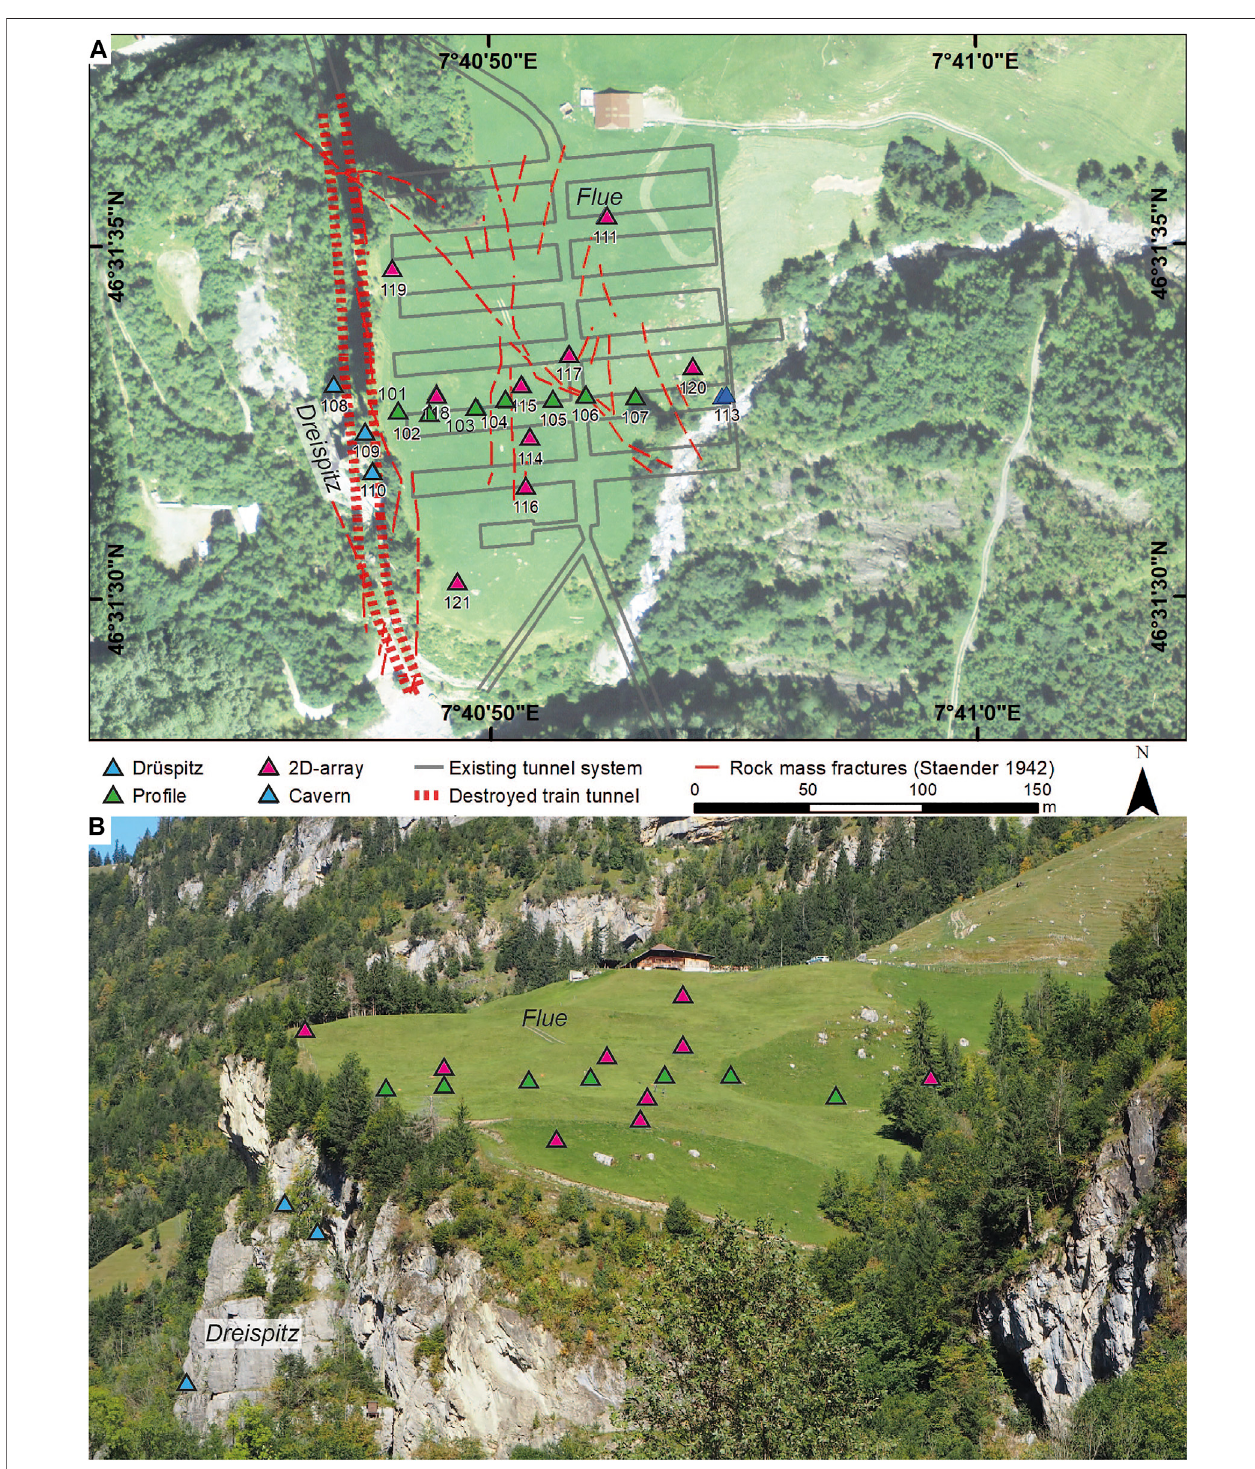
FIGURE 2 | Overview of the measuring con fi guration at Mitholz; (A) orthoimage from swisstopo (2014), the grey lines frame the approximate location of the tunnel system with the destroyed train tunnel ∼ 100 m below the surface of Uf de Flue as well as the location of cracks and fi ssures reported during the construction (Ständer, 1942); coordinates in WGS84; (B) image taken from south facing Uf de Flue and the Dreispitz towers on the left hand side; (A) and (B) The green triangles represent the measuring points along a pro fi le line crossing the tunnel system underneath; the stations marked with pink triangles are arranged for a 2D array at the surface; the light blue triangles represent stations located at Dreispitz and the dark blue triangles represent sensors located within the tunnel system (only in A ).